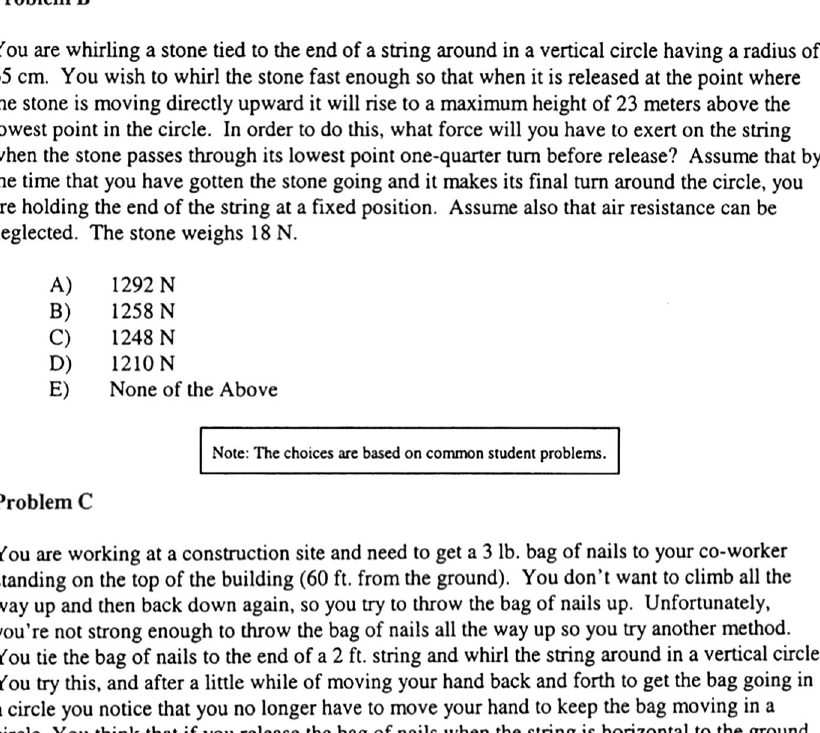
FIG. 1. The multiple-choice and context-rich example problems given to the TAs to illustrate these problem